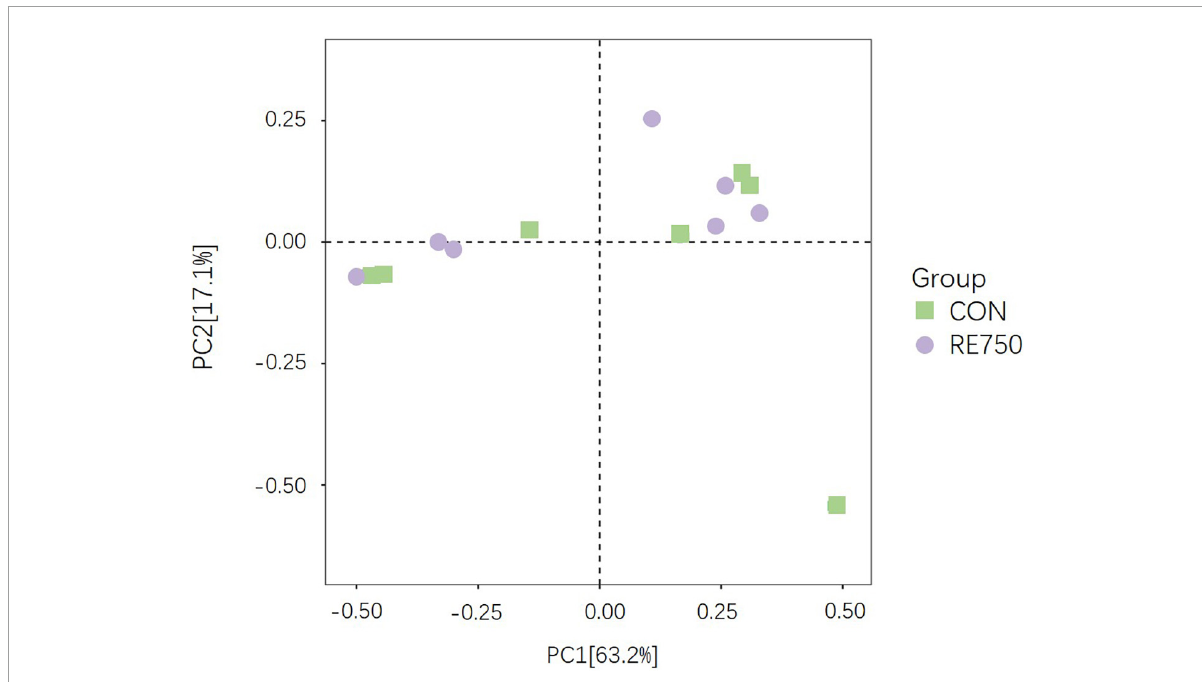
FIGURE1 Principal component analysis ordinated plots of gut microbiota in broilers of control group and RE750.